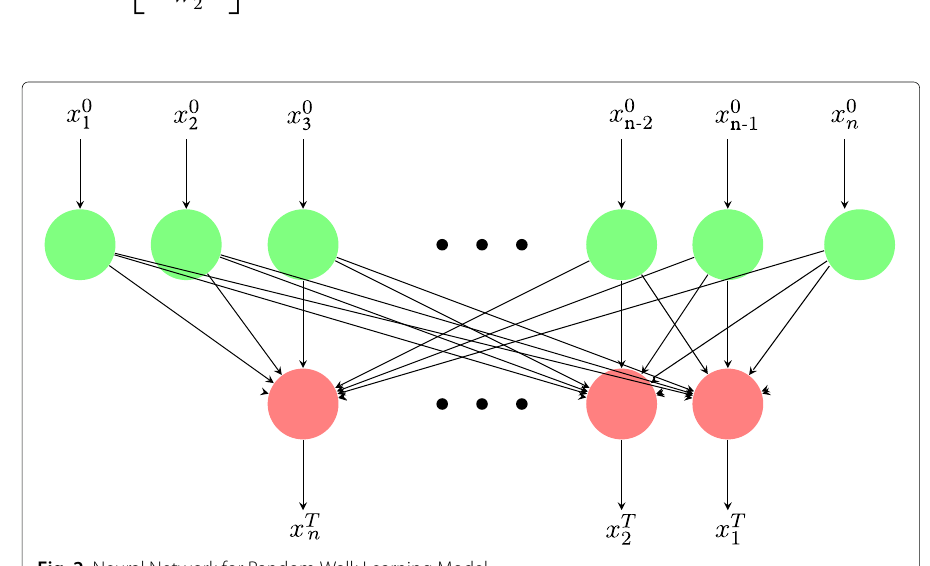
Fig. 2 Neural Network for Random Walk Learning